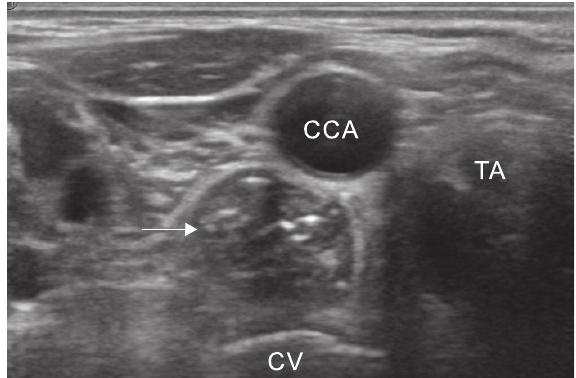
Figure 1 The nodule (arrow indicating) is closely behind the right common carotid artery (CCA), lateral to the trachea (TR), and anterior to the cervical vertebra (CV) on a transverse section.